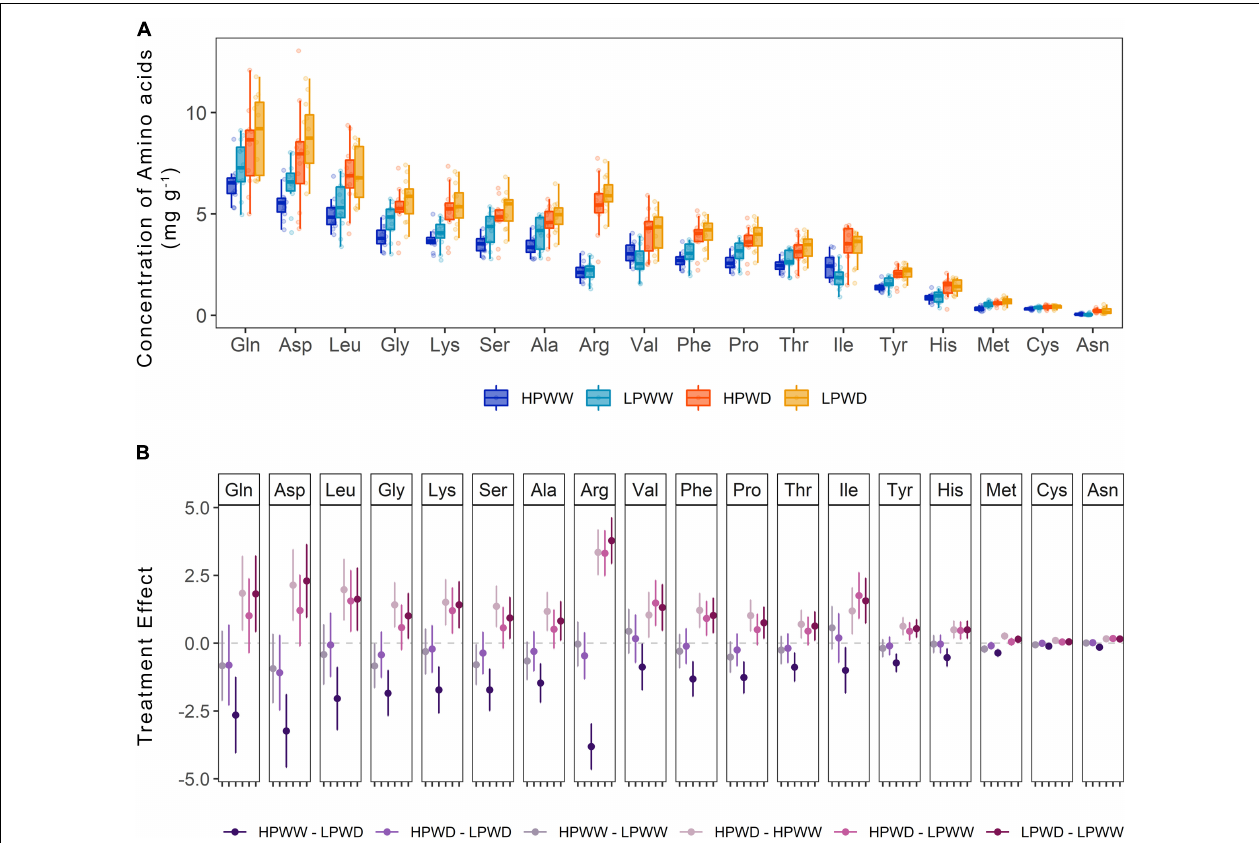
FIGURE 8 | (A) Concentration of amino acids (mg/g) found in the common bean seed tissue subjected to high phosphorus well-watered (HPWW, blue), low phosphorus well-watered (LPWW; light blue), high phosphorus water deficit (HPWD; orange), and low phosphorus water deficit (LPWD; yellow-orange) at harvest. (B) Comparison of treatment effect combination on the concentration of amino acids. Dots represent mean value with upper and lower confidence level; y-axis shows the mean difference in the concentration of amino acids between the treatments; horizontal dash lines illustrate 0 effect, where values close to 0 are not significantly different according to the HSD test at A =